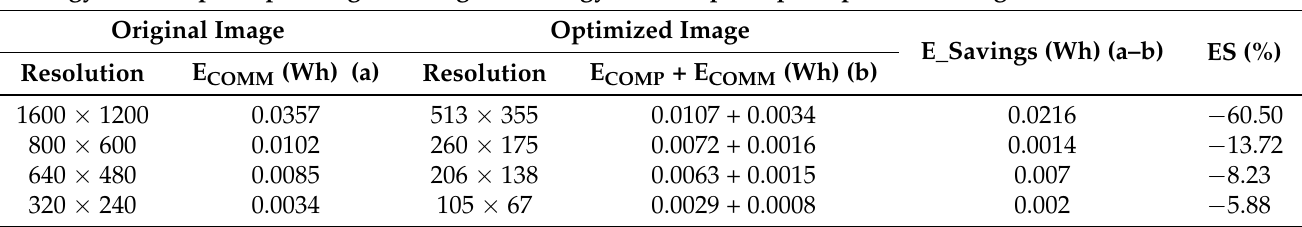
Table 10. Overall energy savings in transmitting an optimized image (considering both its computing and communication energy) as compared to transmitting an original image (communication energy only since no computation